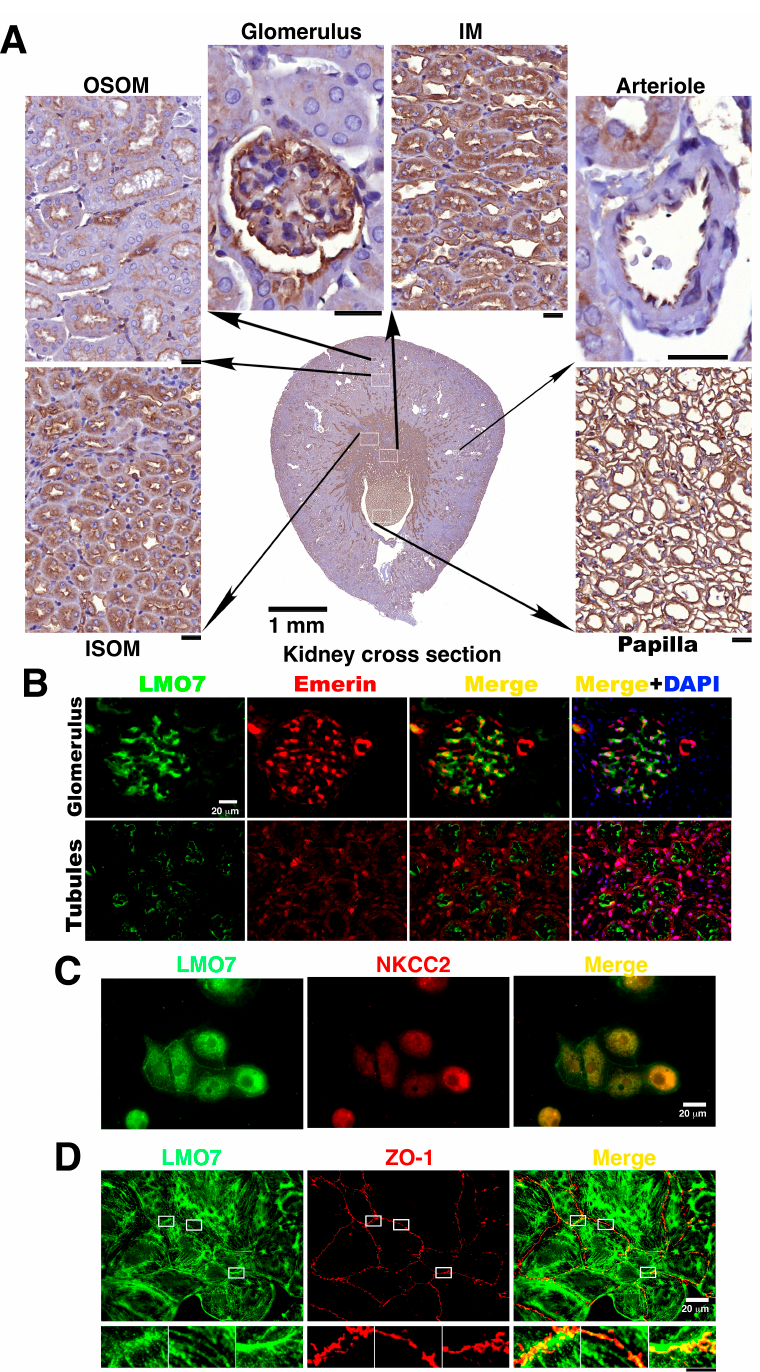
Figure 1. LMO7 expression in kidney. ( A ). LMO7 expression levels are relatively higher in renal cells in the inner stripe of the outer medulla (ISOM), inner medulla (IM), and papilla, and lower in renal cells in the outer stripe of the outer medulla (OSOM). In addition to renal tubules, LMO7 is also detected in the glomerular endothelial cells lining arterioles and podocytes. Bars, 20 µ m. ( B ). To visualize the LMO7 subcellular localization in glomeruli and nephritic ducts, kidney specimens are stained with an antibody against LMO7 (green) and an antibody recognizing emerin (red), which is an inner nuclear protein and is characterized as a LMO7 binding partner. LMO7 is detected in the glomerulus and apical portion of the renal tubular cells. ( C ). In NKCC2 positive renal tubular epithelial cells, LMO7 is present in the periphery of cells and boundaries of two junctional cells. ( D ). In NRK-52E cells, LMO7 associates with zonula occludens-1 (ZO-1), a tight junction